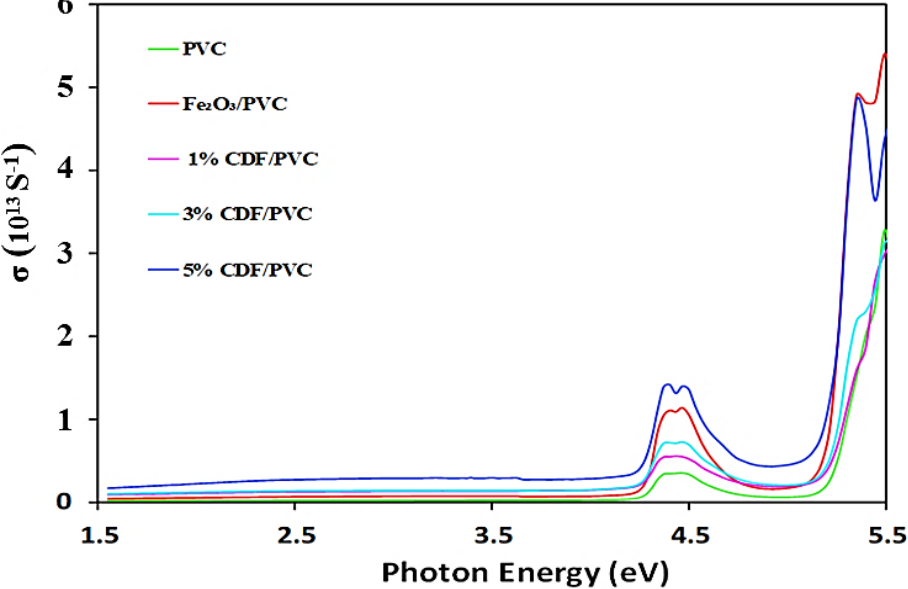
Figure 11. A comparison of optical conductivity spectra of PVC and its composites.